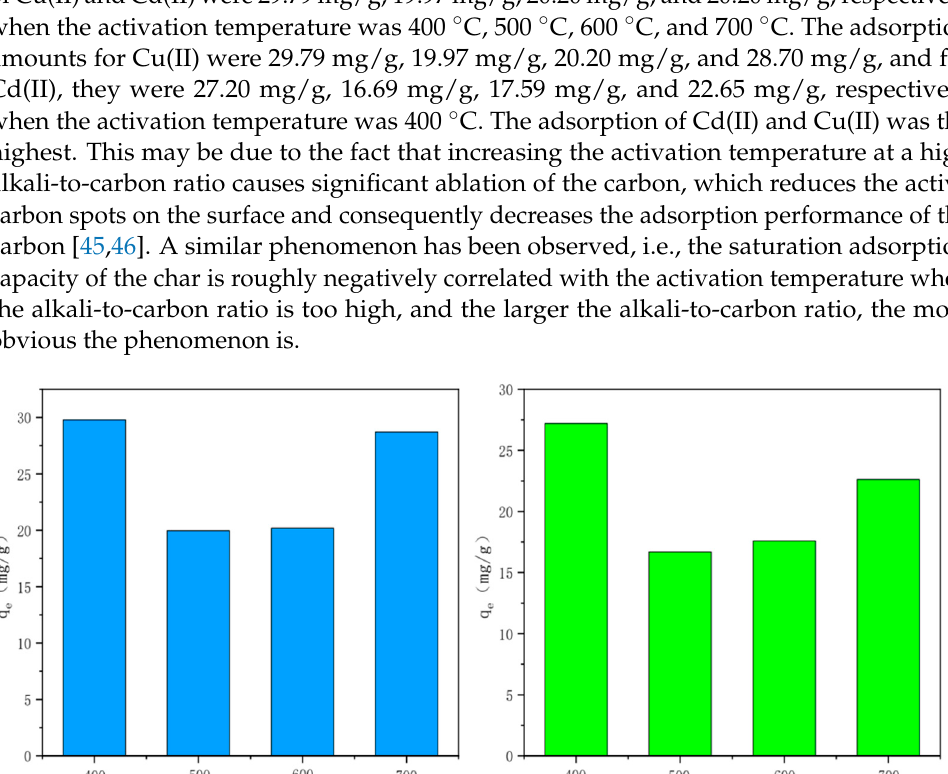
Figure 3. The adsorption capacity of Cu(II)/Cd(II) by KOH-activated modified carbon at various alkali-to-carbon ratios.